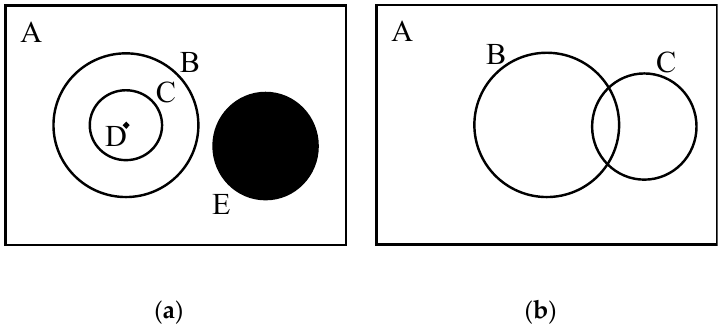
Figure 2. An illustration of the possible types of selection. The Venn diagrams show subsets of some overall population of data A. ( a ) D represents selection of one-of-many. B and C are selections of some-of-many, both are subsets of A but also C is a subset of B, and D is a subset of both. A none-of-many selection would mean an explicit ignoring, illustrated by the set E. ( b ) The selection process can also lead, via separate operations of selecting some-of-many, to the partially overlapping sets B and C. The intersection is a third set which would reflect properties of both B and C.